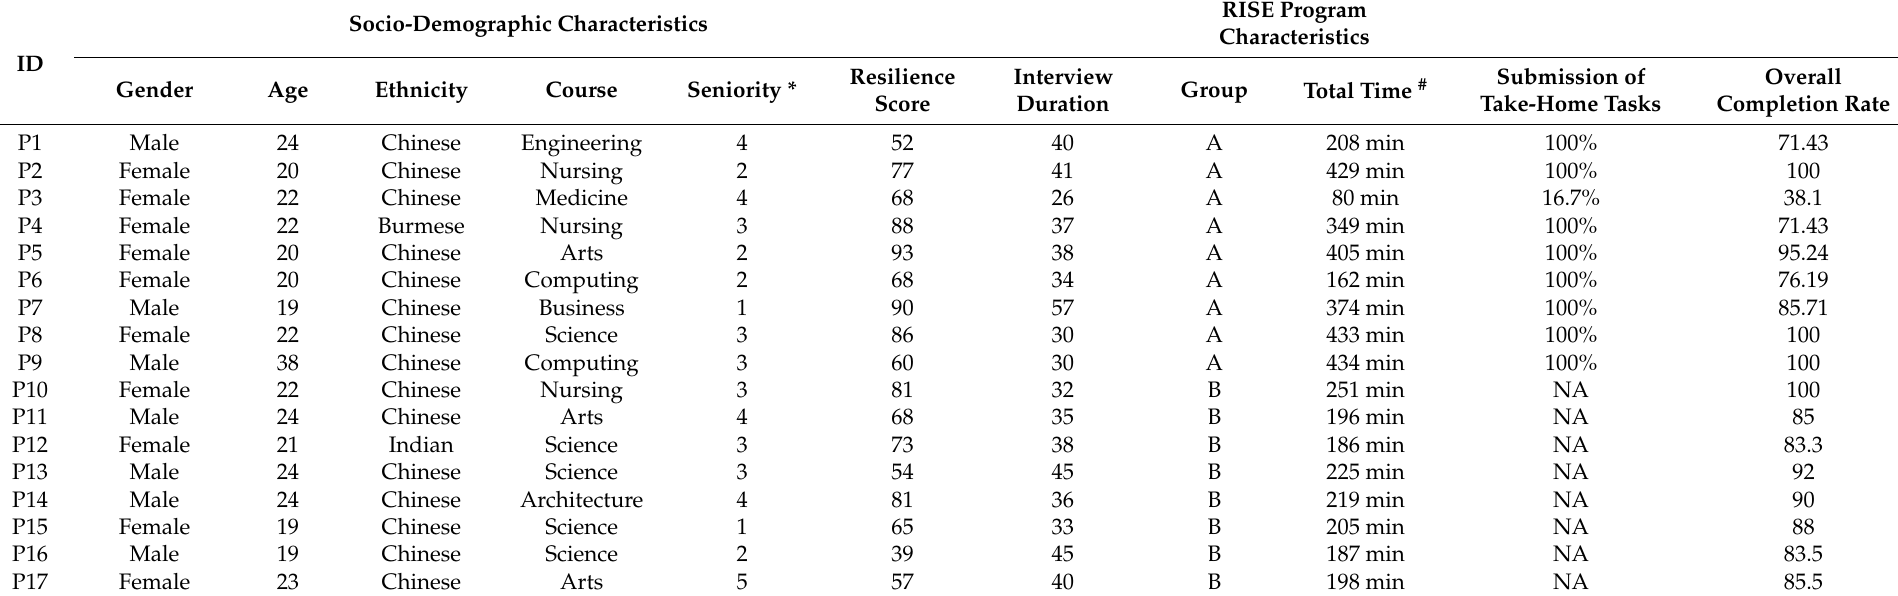
Table 3. Participant